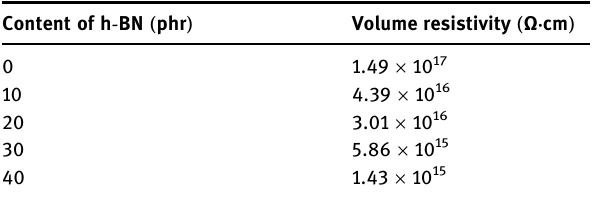
Table 4: Volume resistivity of h - BN/EP composites with di ff erent h - BN content